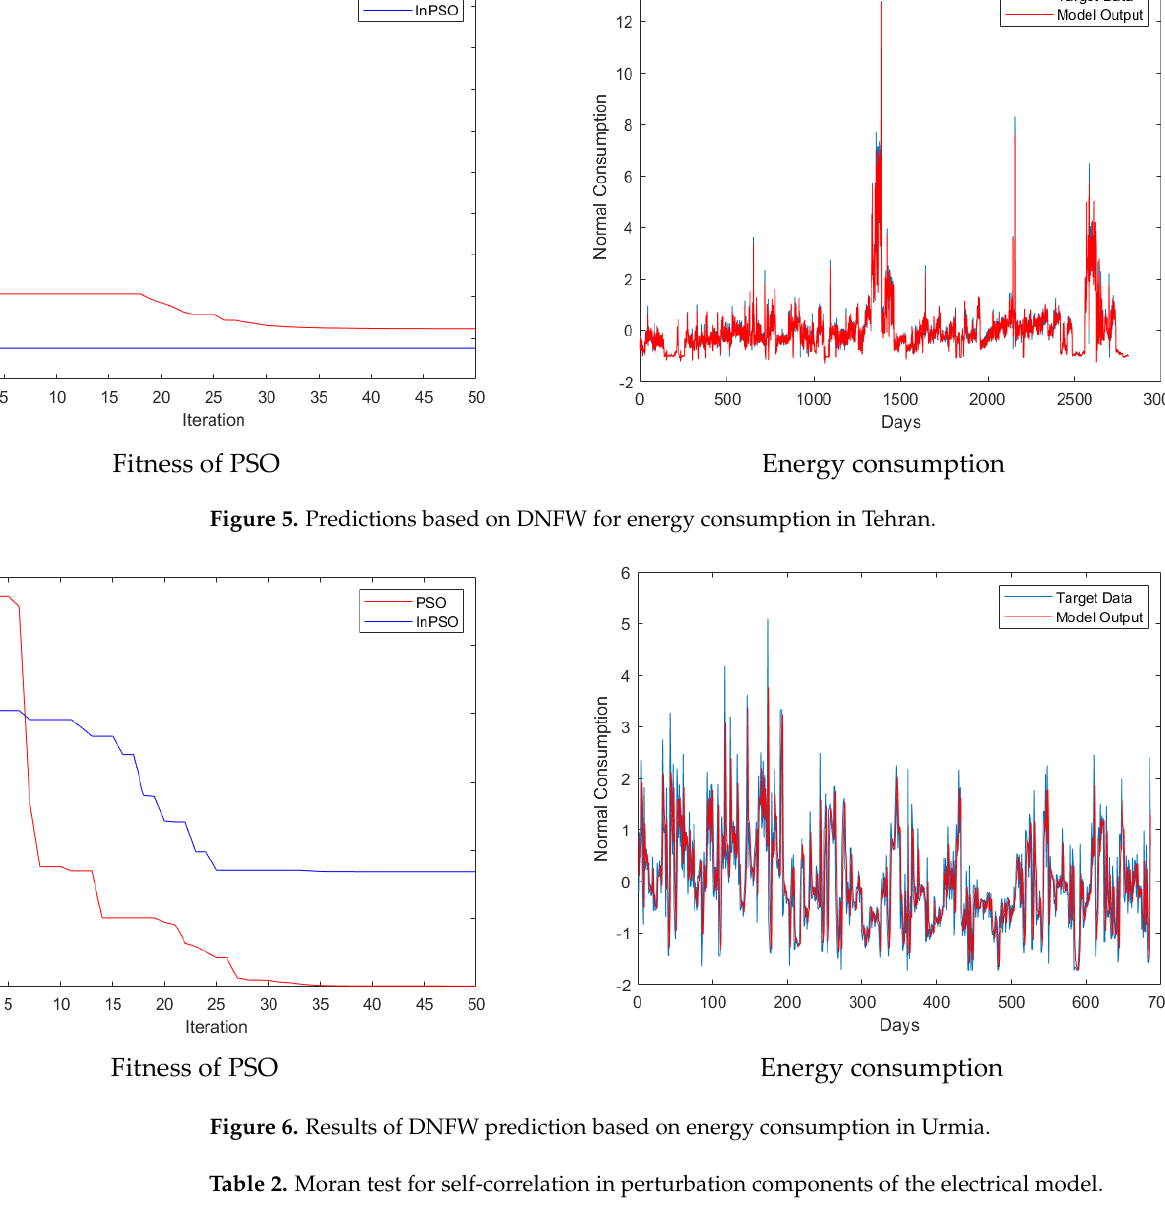
Moran’s I Statistic Marginal Prob. Mean Standard